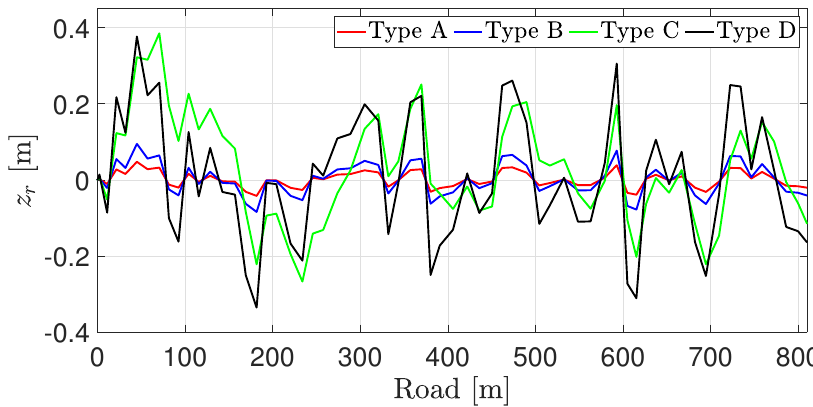
Figure 6. Road displacement profiles of road types A–D for a given speed.